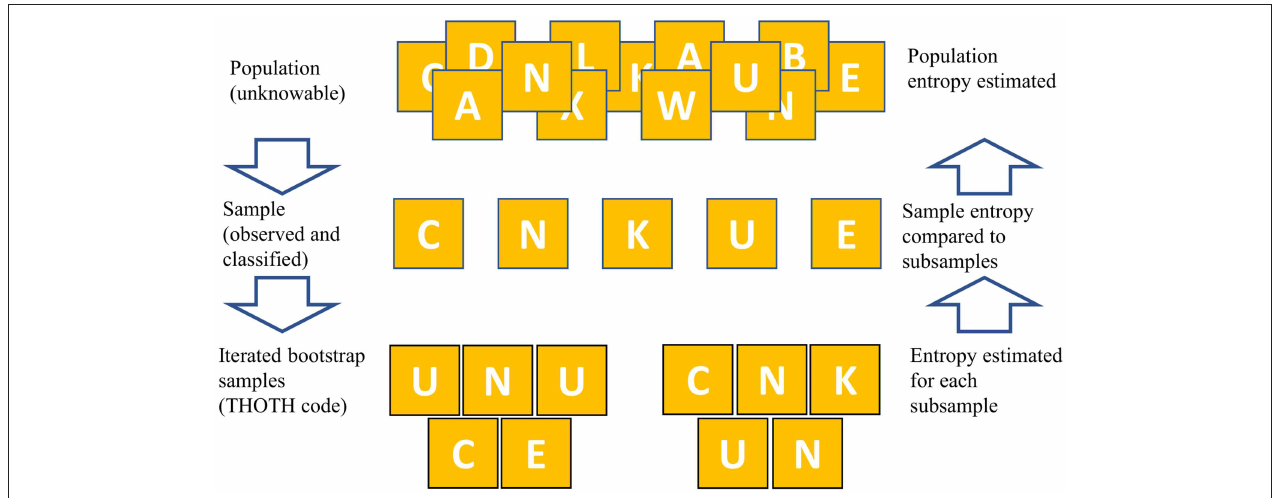
FIGURE 1 | A graphical depiction of the Scrabble example distinguishes between the population (the Scrabble box), the sample (the set of tiles counted), and the iterative subsamples (the artificial datasets made based on the sample). The population is sampled at first, and then the EESB iteratively resamples the sample to produce numerous distributions similar to the original sample through the process called bootstrapping. These then inform our estimates of the bias between the sample and the subsamples, which in turn informs our estimate of the bias between the diversity of the sample and the diversity of the population, classified by a given